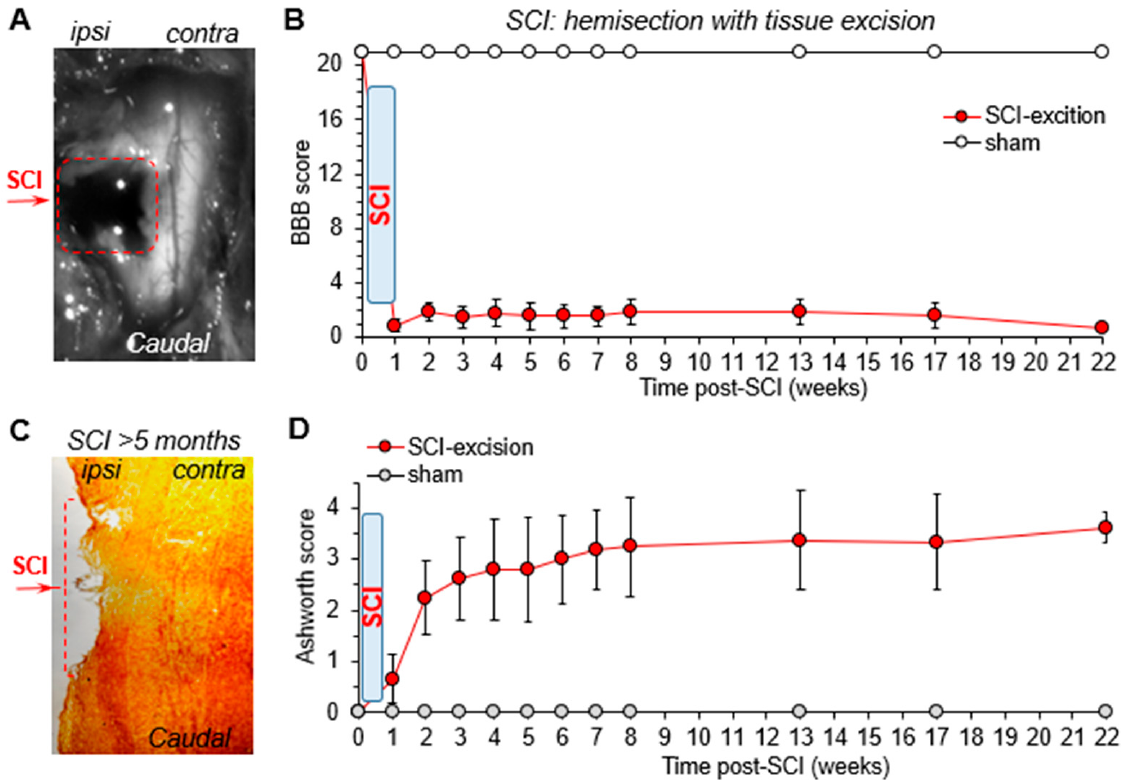
Figure 1. Severe neurotrauma of the spinal cord results in persistent, non-recovered motor disability. ( A ) An image of the spinal cord region (transmitted light) subjected to hemisection with tissue excision. ( B ) The time course of the BBB rating of ipsilateral motor function in experimental groups; animals were ~1 month-old at the time of surgery. ( C ) One example image of a sagittal section of the spinal cord (hematoxylin-eosin staining), showing the hemisection region at 5 months after SCI. ( D ) The time course of Ashworth scaling for muscle tone on the ipsilateral to injury side. Animal groups are the same as for B. Red dashed lines denote the lesion area on both images. Data are mean ± SEM.